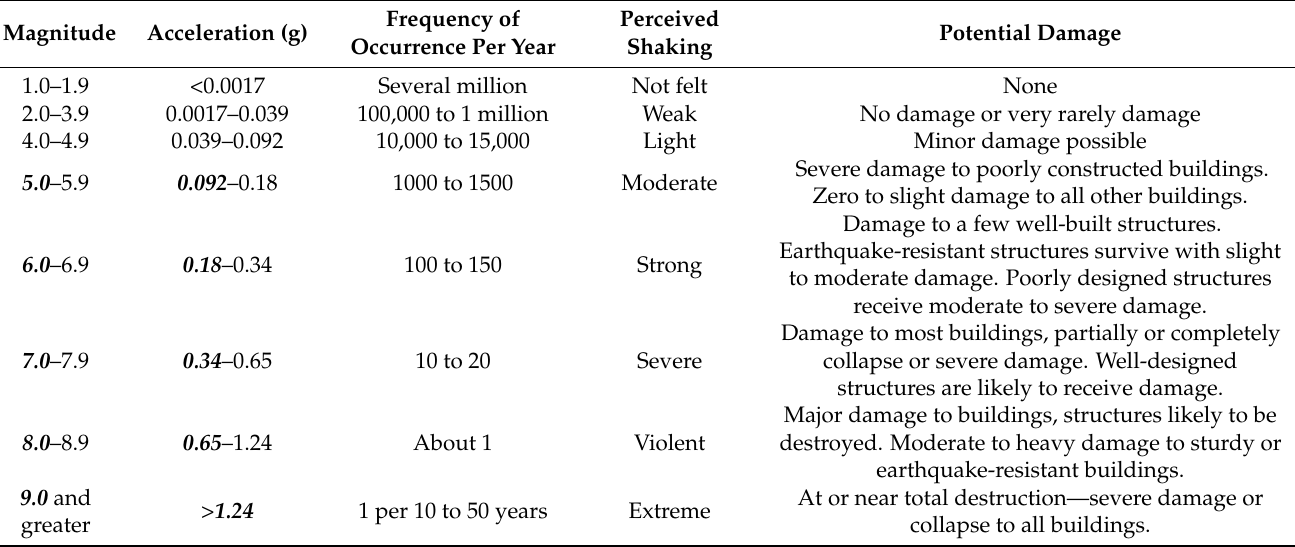
Table 2. Summary of the earthquake magnitude and the corresponding peak ground acceleration, frequency of occur- rence, perceived shaking and potential damage (adapted from www.usgs.gov; accessed on 22 March 2021). The selected magnitudes and their accelerations were marked in bold and